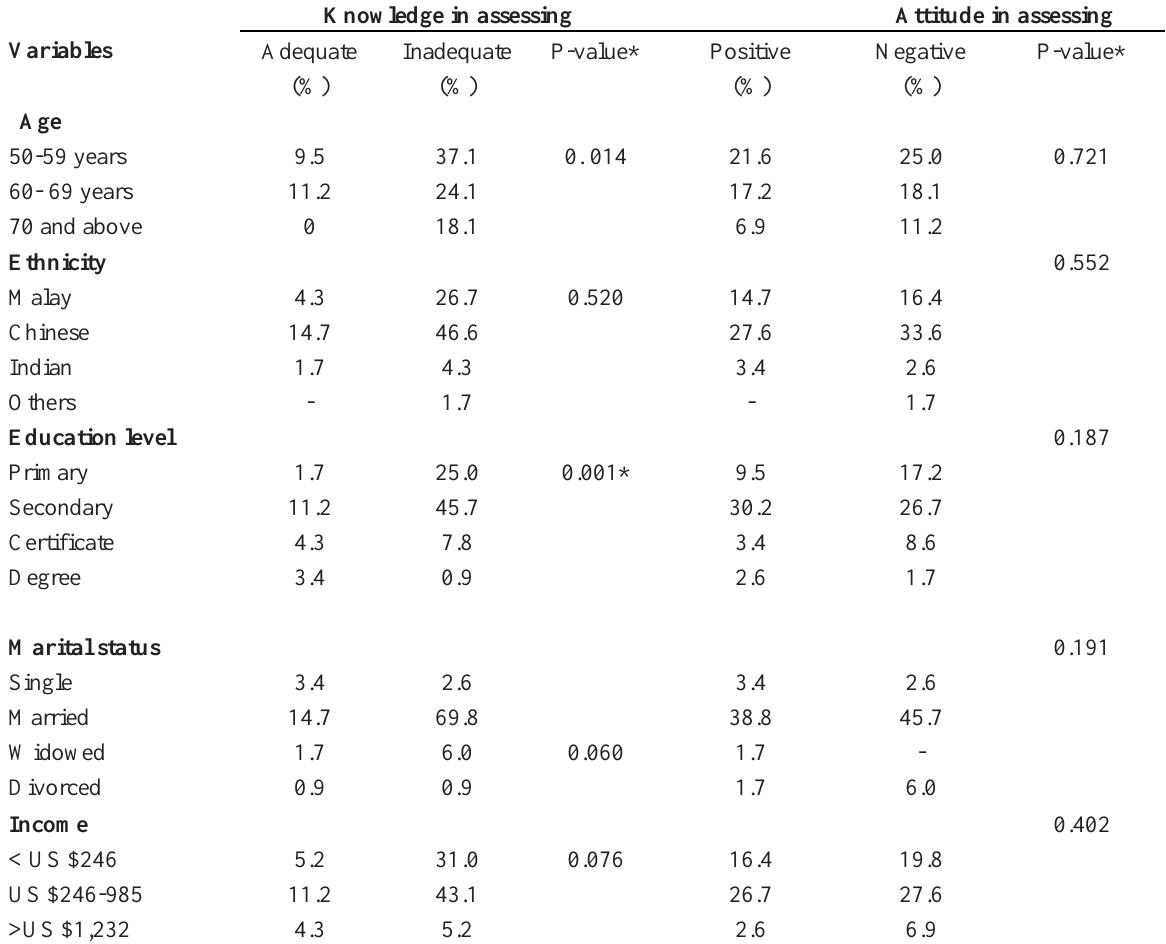
Table 1: Association between knowledge attitude and sociodemographic characteristics (Based on N=116) (54.3%). The result showed that 20.7% had adequate knowledge range for osteoporosis, while 79.3% had inadequate knowledge